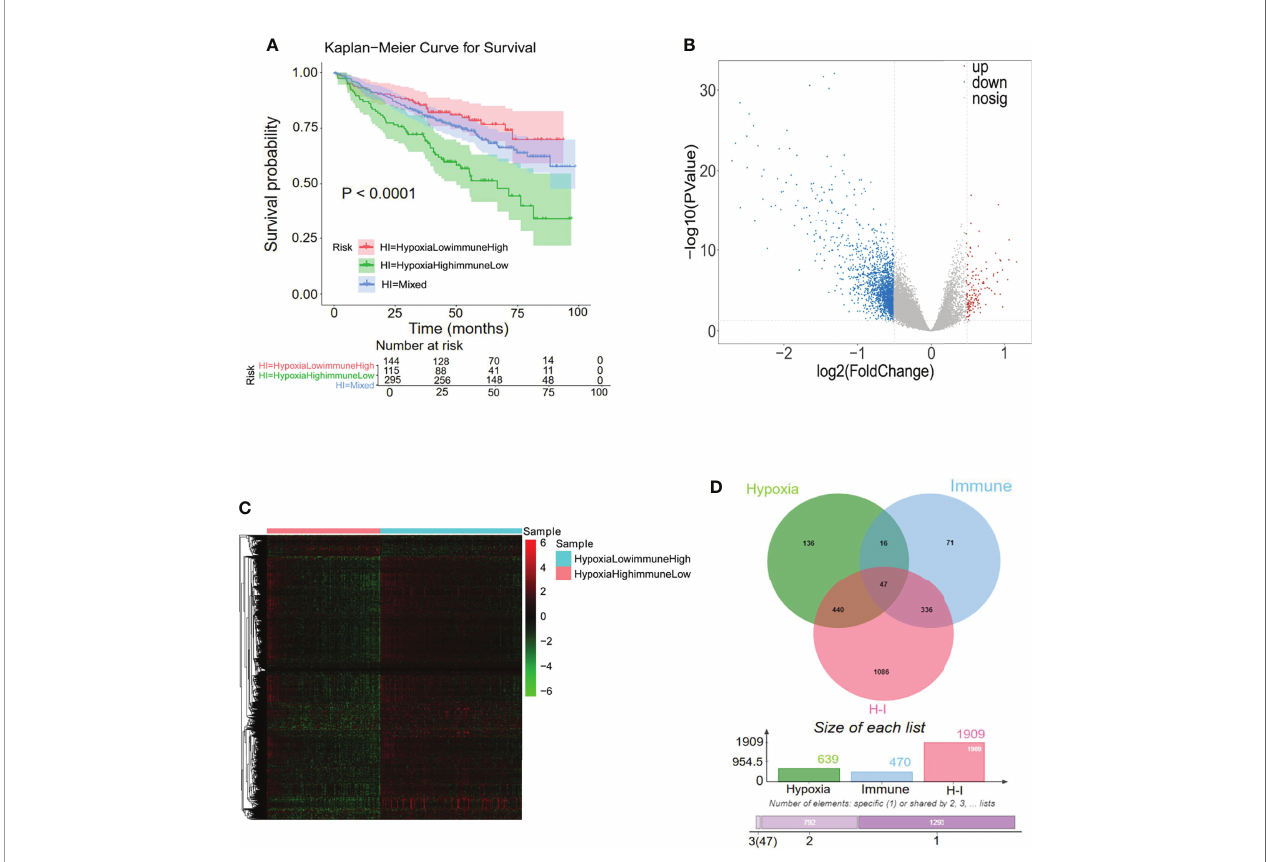
FIGURE 4 | Differentially expressed analysis of hypoxia – immune-related 47 genes for MM. (A) Kaplan – Meier analysis of the different groups based on the hypoxia and immune status to predict patient survival. (B, C) In total, 1,909 hypoxia – immune-related differentially expressed genes (DEGs) were identi fi ed with hierarchical cluster analysis for MM. (D) Forty-seven hypoxia – immune-related genes were obtained from intersecting with 639 hypoxia-related DEGs, 470 immune-related DEGs, and 1,909 hypoxia – immune-related